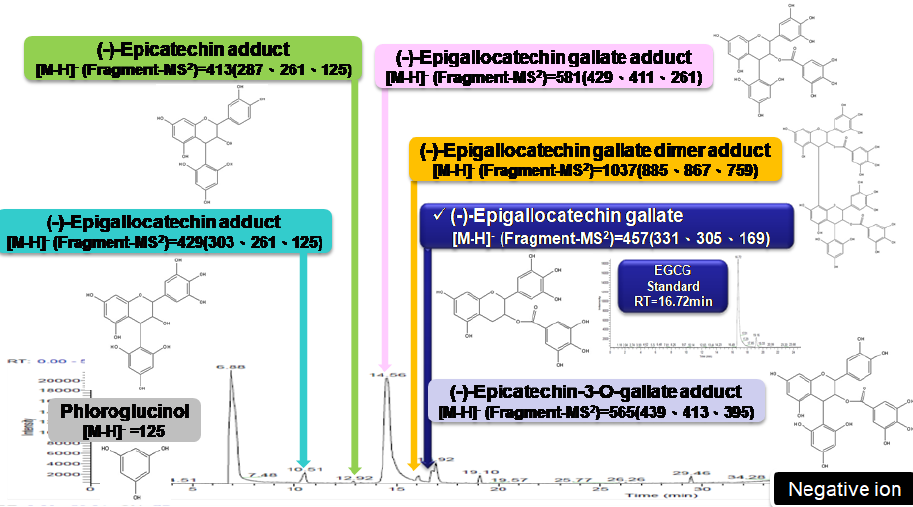
Figure 7. Phloroglucinol degradation for HH-F3 (LC/MS profile).